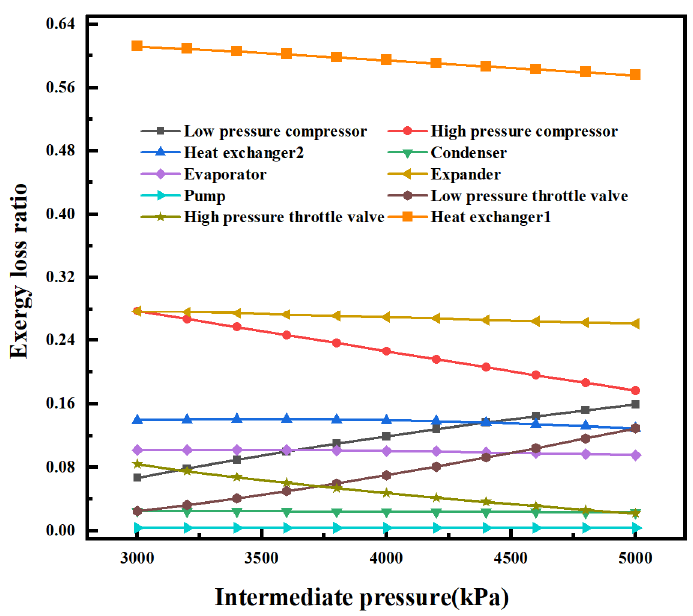
Figure 8. Exergy loss rate of each component of the coupling system varied with the intermediate